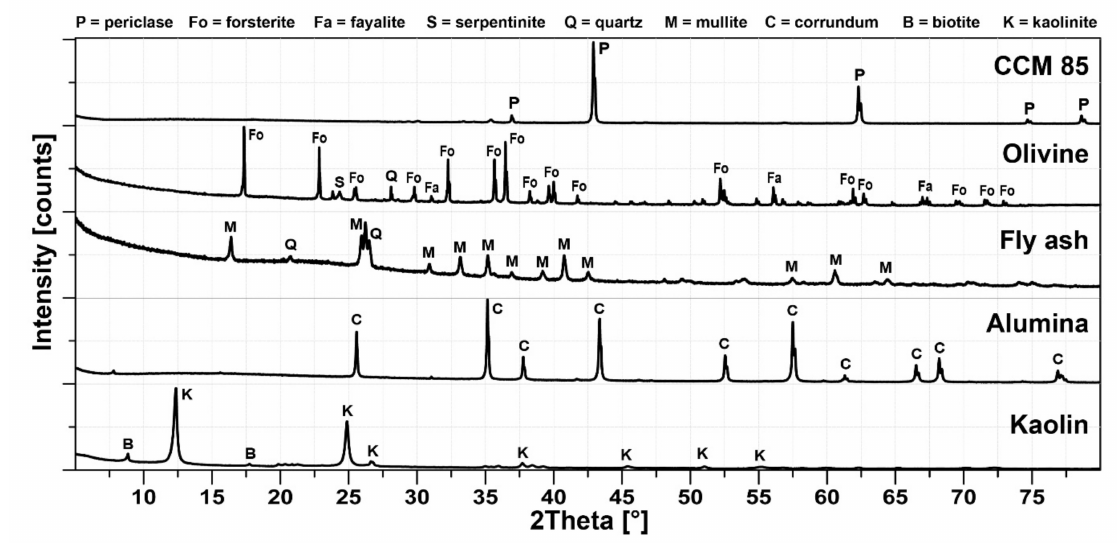
Figure 3. X-ray di ff raction analysis of the used raw